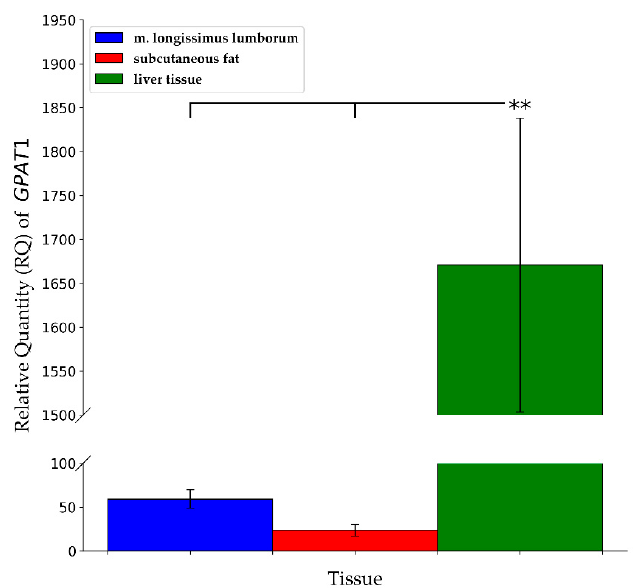
Figure 1. Relative quantity (RQ) of GPAT1 transcript abundance in different tissues (m. longissimus lumborum, subcutaneous fat, liver tissue) across all breeds together (** p ≤ 0.01). Data are presented as means ± SEM (standard error of the mean).